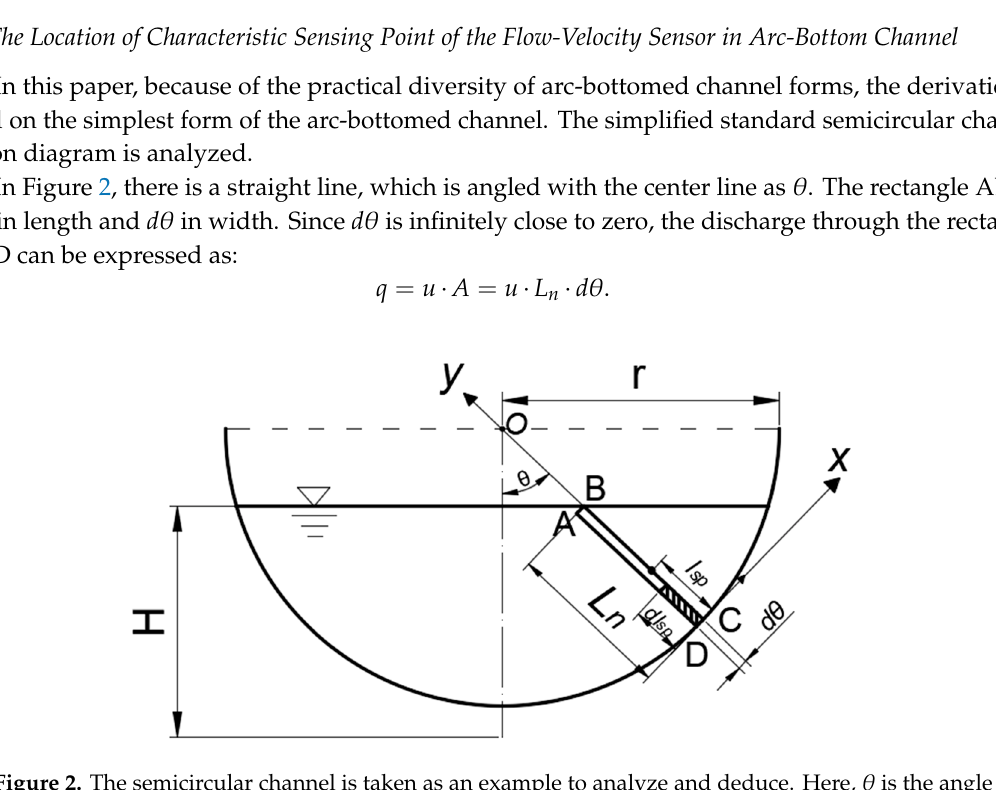
Figure 2. The semicircular channel is taken as an example to analyze and deduce. Here, θ is the angle between the center line and the line passing through the circle center O. l sp is the distance between characteristic sensing point to the sidewall.